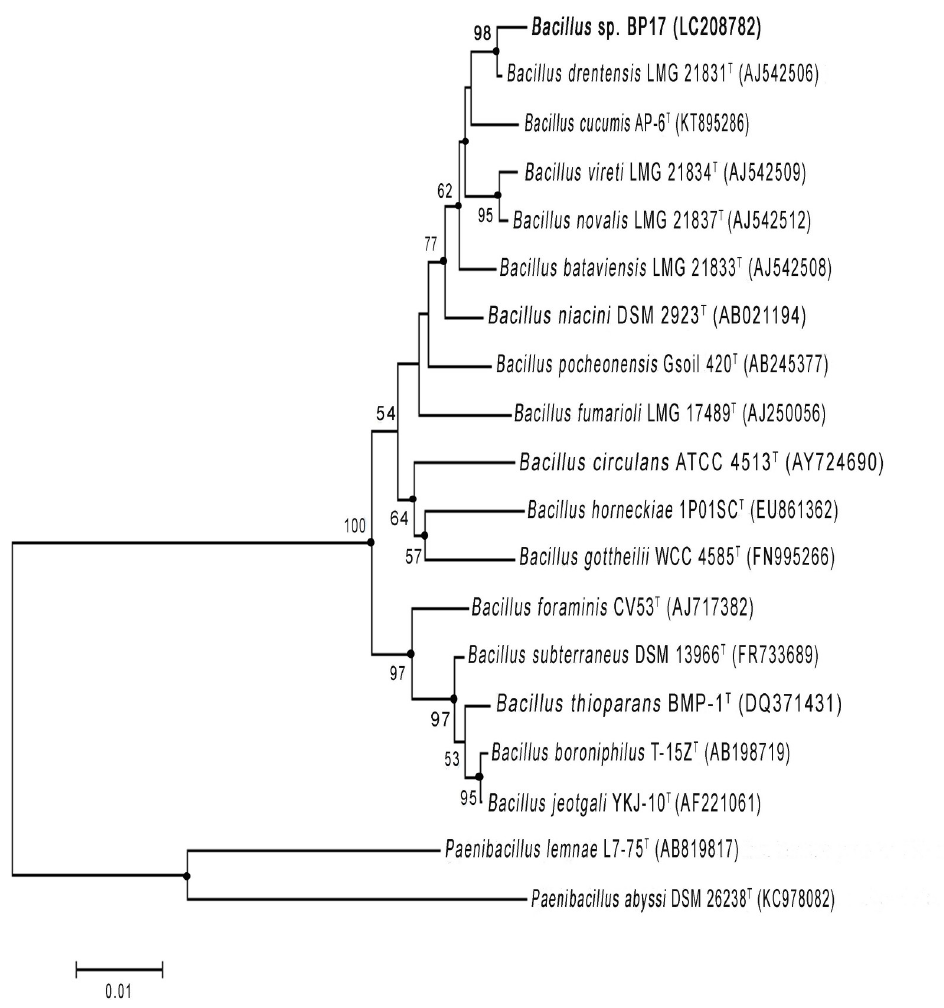
Fig 2. Neighbor-joining tree based on 16S rRNA gene sequences showing phylogenetic relationship between strain BP17 and closely related taxa of the genus Bacillus . Paenibacillus lemnae L7-75 T and Paenibacillus abyssi DSM 26238 T were used as outgroup. Only bootstrap values above 50% (percentages of 1000 replications) are shown. Nodes marked with filled circle indicate branches were also recovered in the reconstructed trees using the maximum- likelihood and maximum-parsimony method; Bar 0.01 nucleotide substitutions per